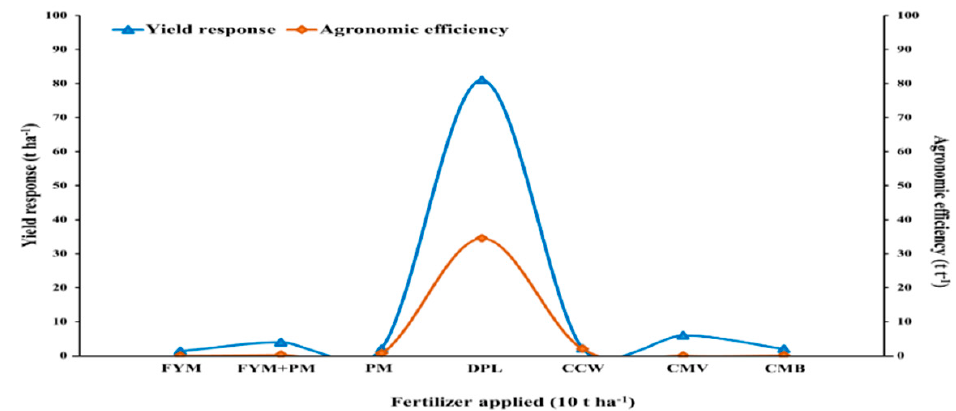
Figure 1. Positive quadratic correlation between the yield response and AE, where application rate was kept constant at 10 t ha − 1 as dry weight basis for all the used fertilizers. This curve behaves quadratically as the highest exponent of the variable in the curve-equation was a square and the relationship found positive as increasing one variable increases the other one. Details provided in Table 2. FYM: Farmyard manure, PM: Poultry manure, DPL: Dried poultry litter, CCW: Composted cattle waste, CMV: Cattle manure vermicompost, CMB: Cow manure biochar.